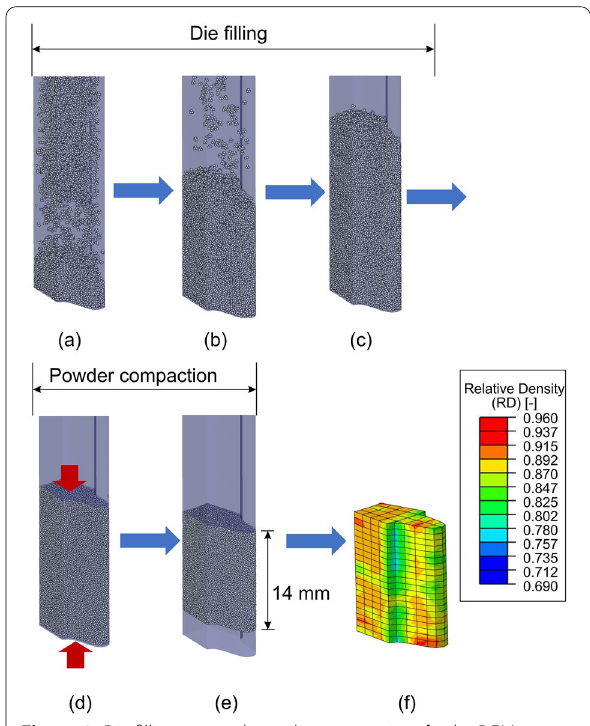
Figure 9 Die filling a – c and powder compaction d , e by DEM simulation; resulting density distribution in FE model f